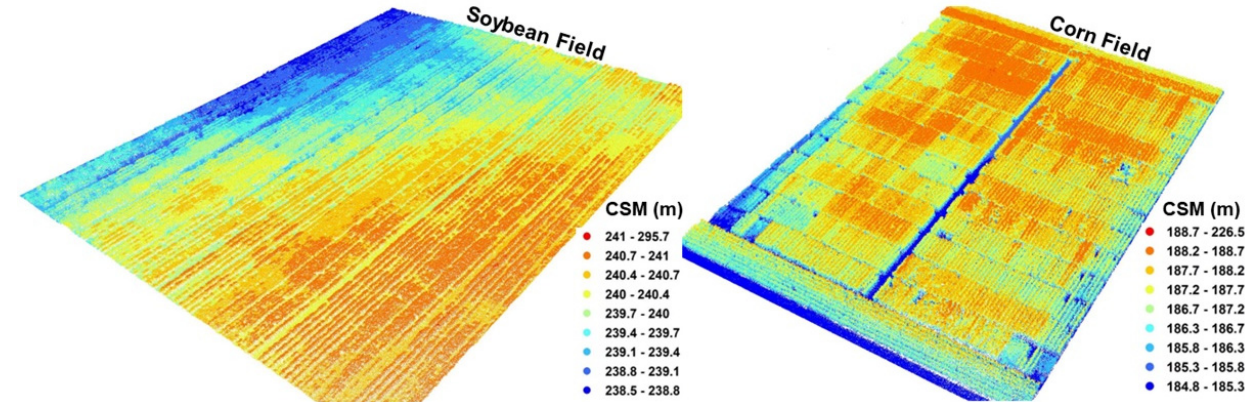
Figure 5. Preprocessed LiDAR point clouds of soybean and corn fields (note that the height dimension values of the point clouds are the elevation values, not the canopy height values).